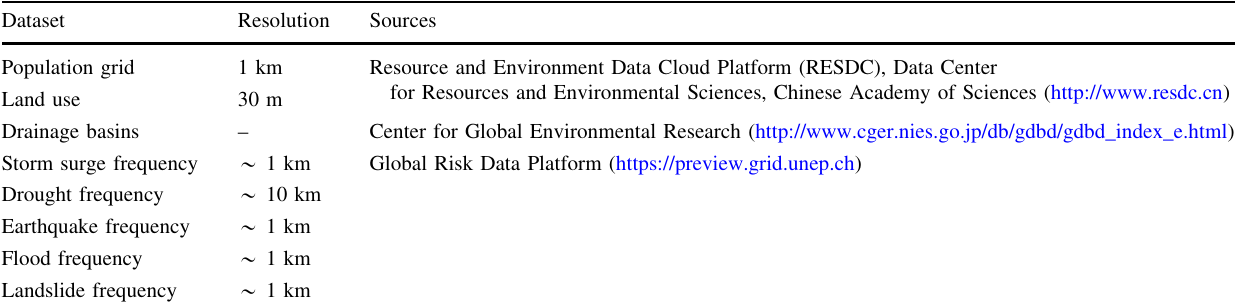
Table 1 Description of the datasets used in the analysis of the changes of population, built-up land, and cropland exposure to natural hazards in China from 1995 to 2015